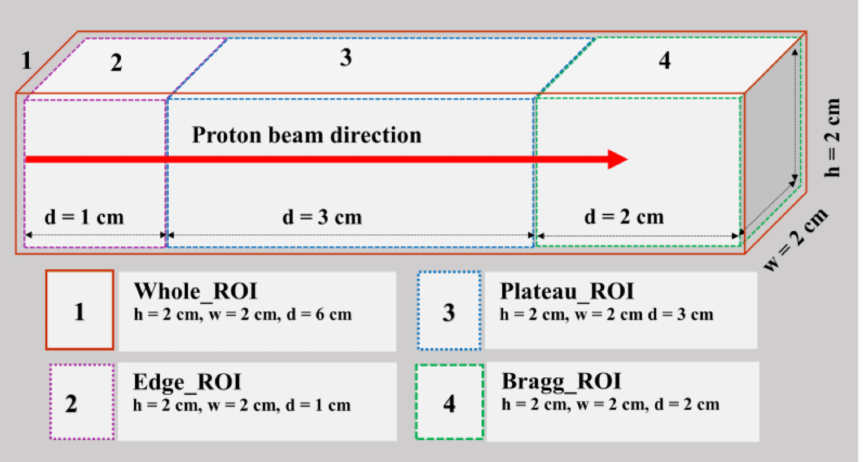
Figure 4. The four regions of interests (ROIs) with their respective height (h), width (w) and depth (d) values used in the spectral analysis